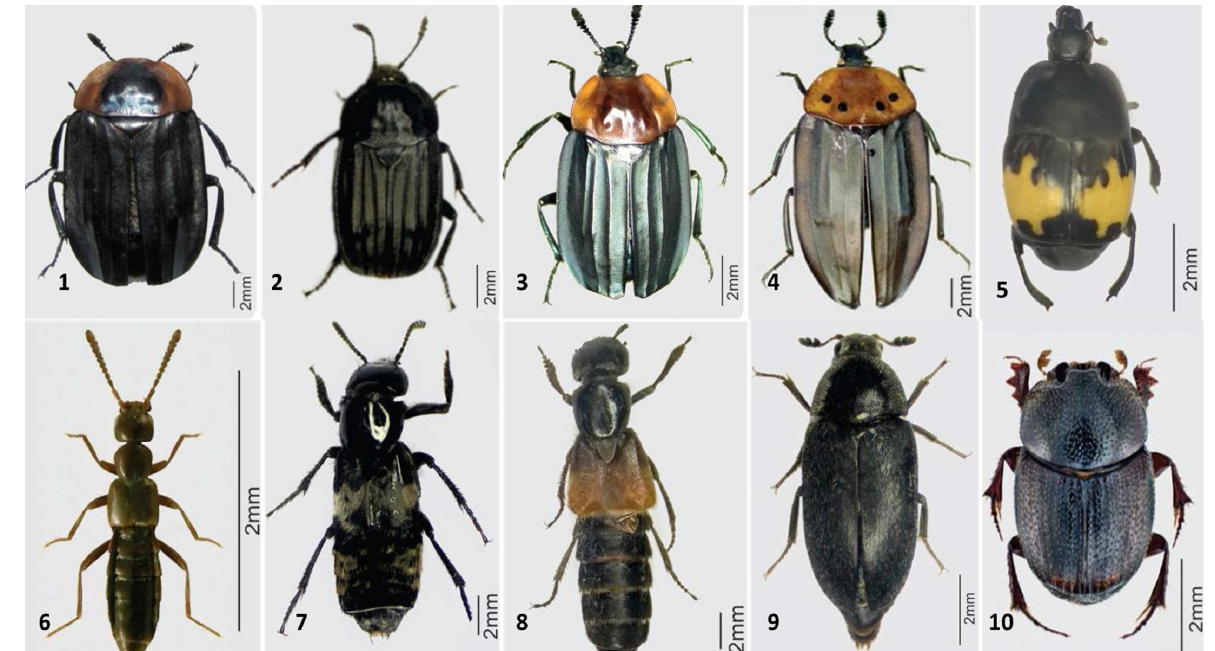
Figure 1. Coleoptera species collected and identified during the present study 1. Thanatophilus minutes (Kraatz) 2. Necrophila ( Calosilpha ) cyvaniventris (Motschulsky) 3. Necrophila ( Calosilpha ) ioptera (Kollar and Redtenbacher) 4. Necrophila ( Deutosilpha ) rufithorax (Wiedemann) 5. Saprinus interruptus (Paykull) 6. Aleochara nigra Kraatz 7. Creophilus maxillosus (Linnaeus) 8. Creophilus flavipennis (Hope) 9. Dermestes maculatus Brahm 10. Onthophagus cervus (Fabricius).